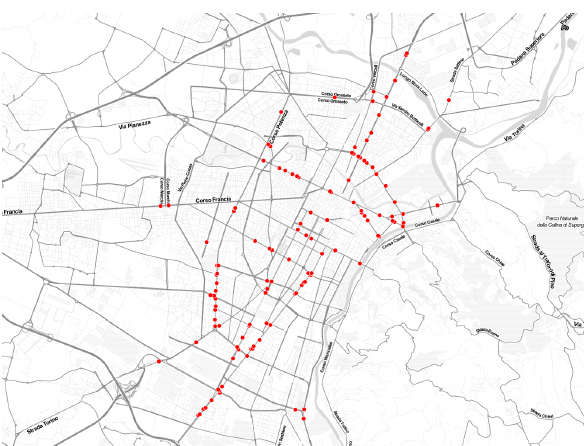
Figure 1. Geographical location of all data sources (red dots) in the urban area of